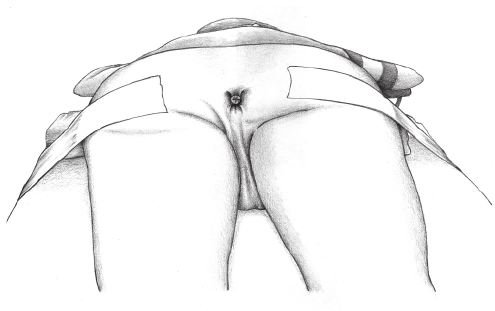
Figure 2 - The gluteals held back.